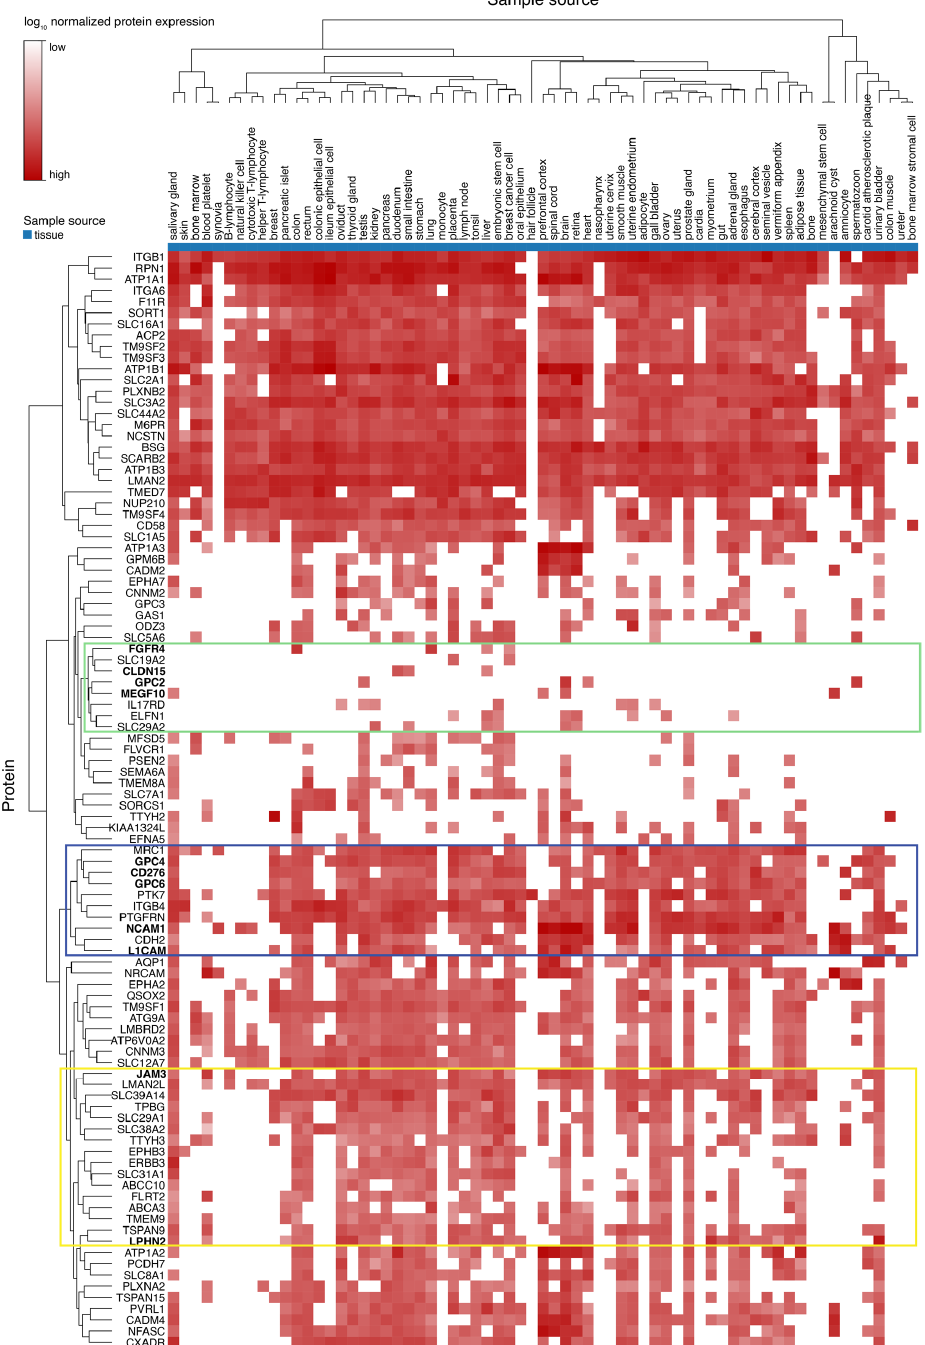
Figure 5. Top100 proteins expression in normal tissues. Protein expression levels expressed as normalized iTop3 values for the selected Top100 proteins in normal tissues were generated with the ProteomicsDB database analytic toolbox expression heat map by selecting Tissue, MS1, Top3, and SWISS-PROT only. FGFR4 and GPC2 (green square) were detected in a few normal tissues. GPC4, CD276, N1CAM, and L1CAM (blue square) cluster close together and are expressed at low-medium levels in most of the considered normal tissues. AGRL2 (indicated as LPHN2 in the figure) and JAM3 (yellow square) cluster loosely together and are detected in several normal tissues but mostly at low levels. The values represented can be found in Supplementary Information Table S15, and are the mean total sum normalized protein expression value across all samples that are stored in the database